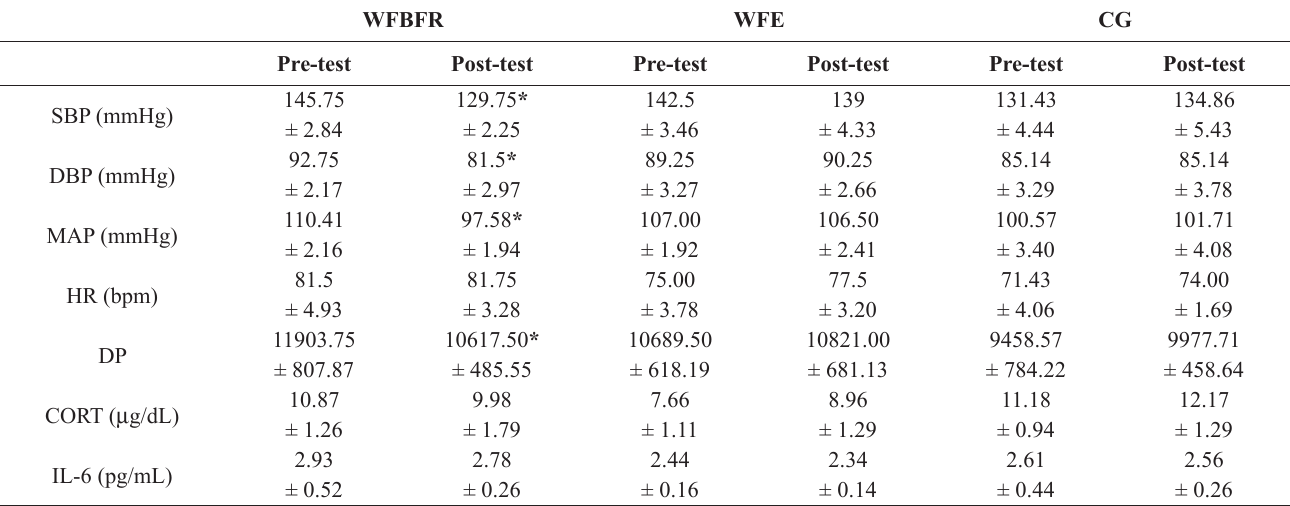
Table 1. Effects of resistance exercise (low intensity wrist flexion exercise) on cardiovascular parameters and plasma biomarkers in subjects with blood flow restriction (WFBFR), without flow restriction (WFE) and control group